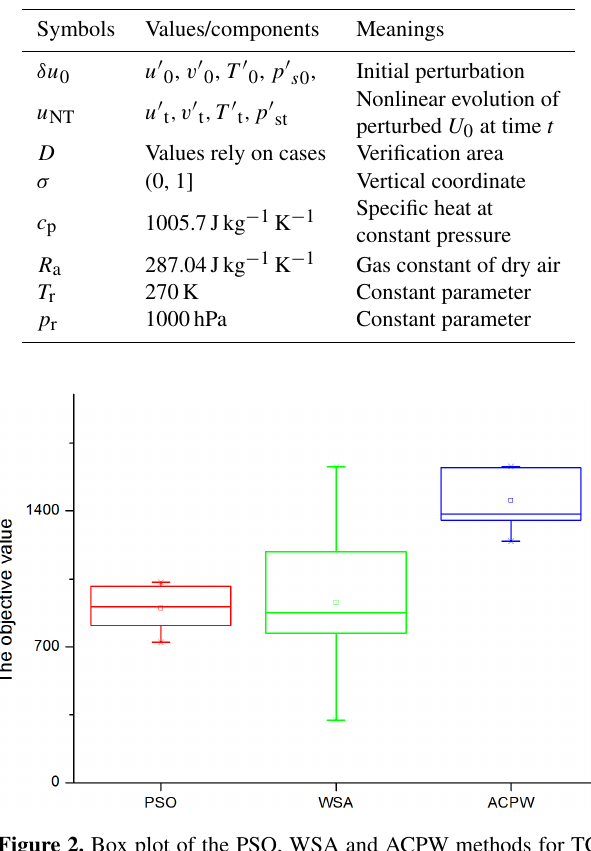
Table 2. The meanings of all symbols.